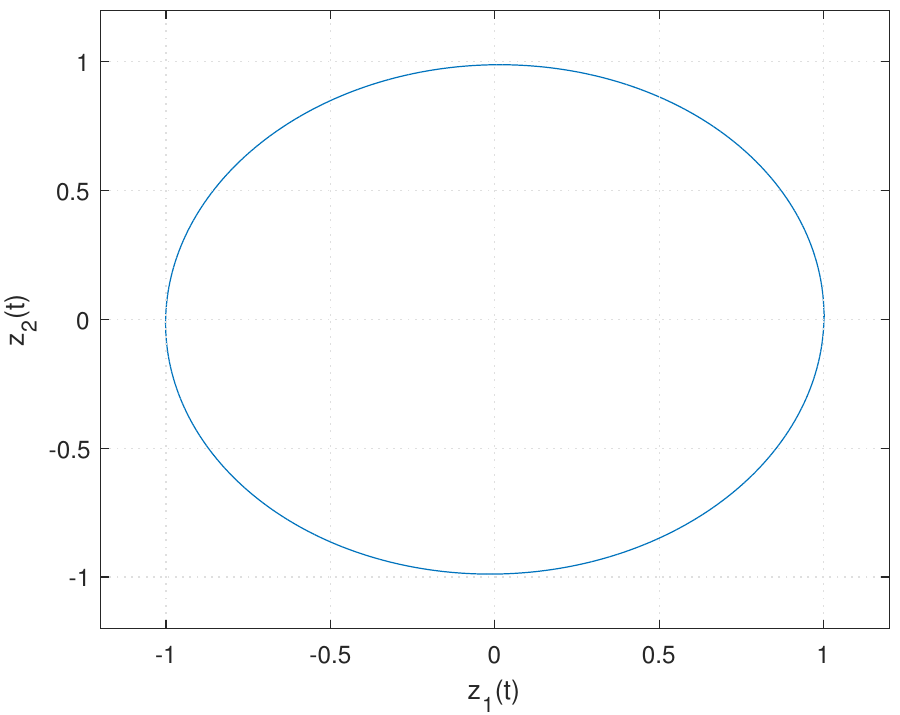
Figure 2. The set of admissible initial values for Example 1. Based on the obtained parameters, the simulation results about the trajectories of the system state z ( t ) and the controller u ( t ) are displayed in Figure 3. We can find that the closed-loop system (2) can achieve the asymptotical stability with the designed saturating